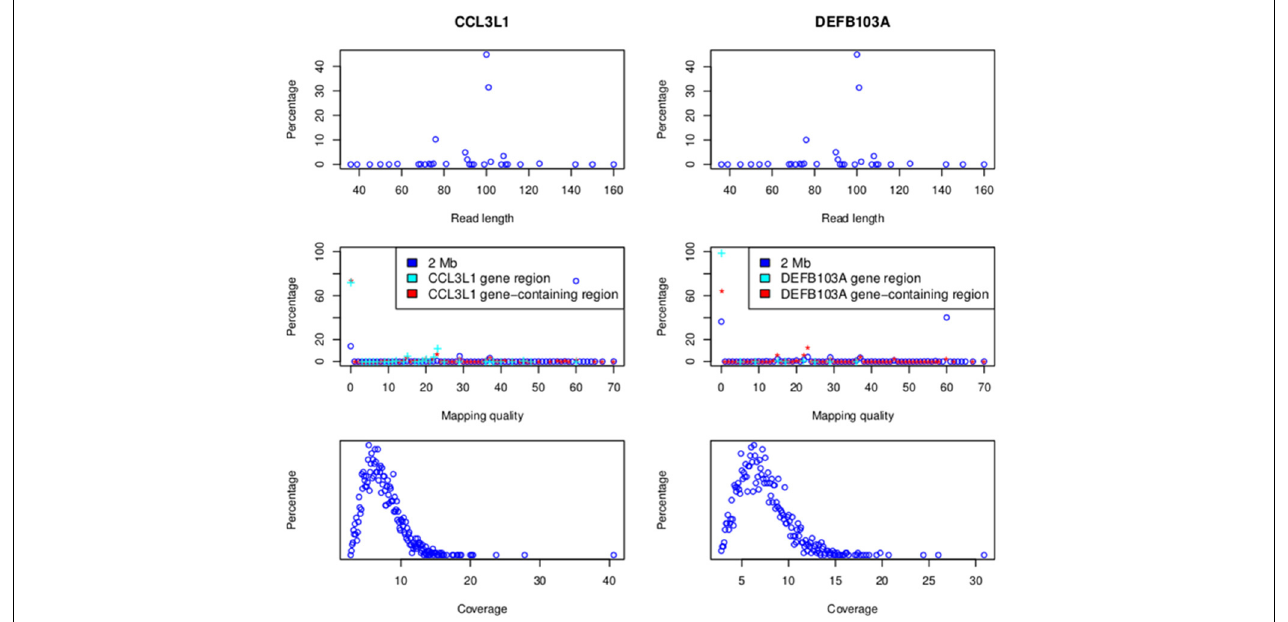
FIGURE 4 | Read lengths and mapping qualities (top), mapping qualities (middle) and average read depth (bottom). Data for the 2MB CCL3L1 region are on the left and the 2Mb DEFB103A region on the